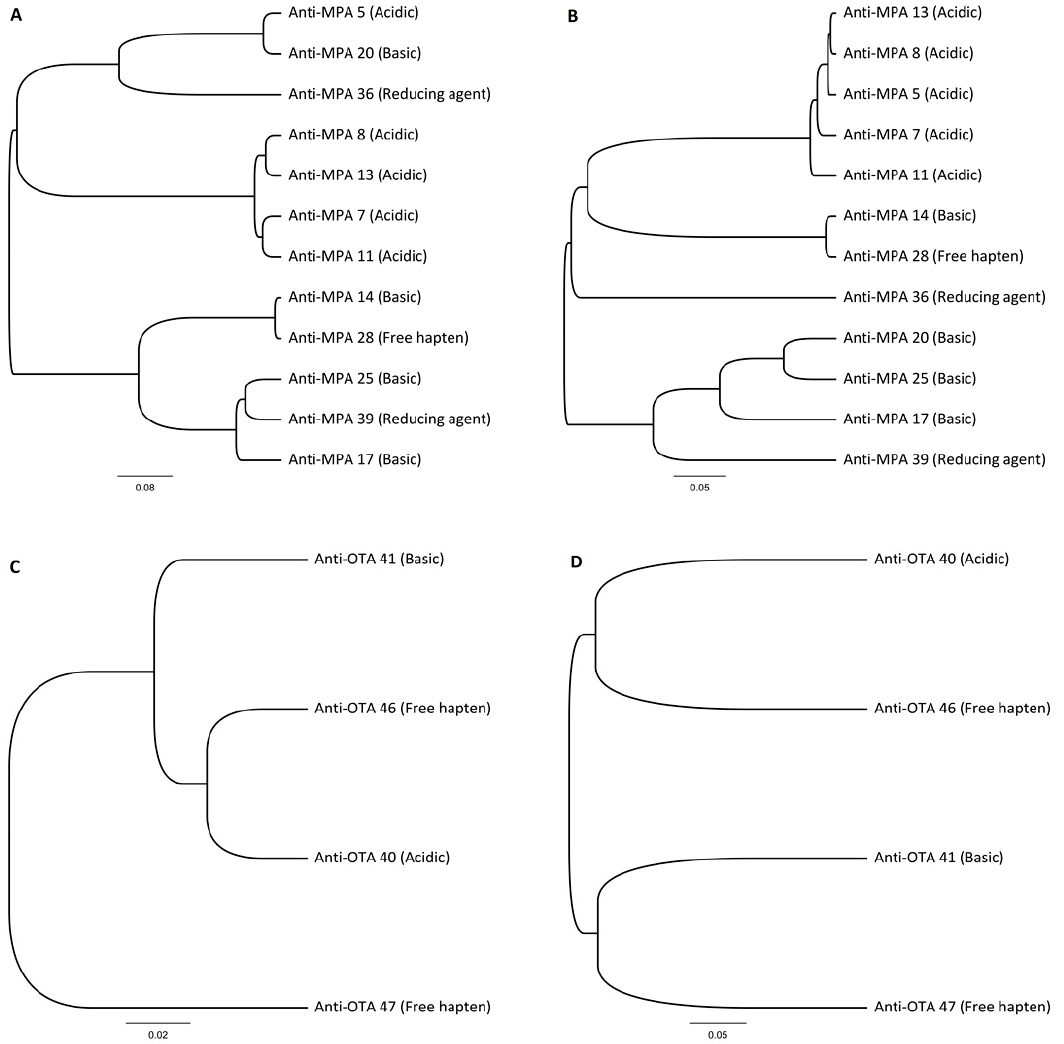
Figure 1. Amino acid sequences of variable regions of recombinant antibodies analysed with unweighted pair group method with arithmetic mean (UPGMA) using Geneious 6.1 software (Biomatters, Auckland, New Zealand). ( A ) Heavy chain variable regions of anti-MPA clones; ( B ) Light chain variable regions of anti-MPA clones; ( C ) Heavy chain variable regions of anti-OTA clones; ( D ) Light chain variable regions of anti-OTA clones. The elution strategy for each clone is indicated in parenthesis.